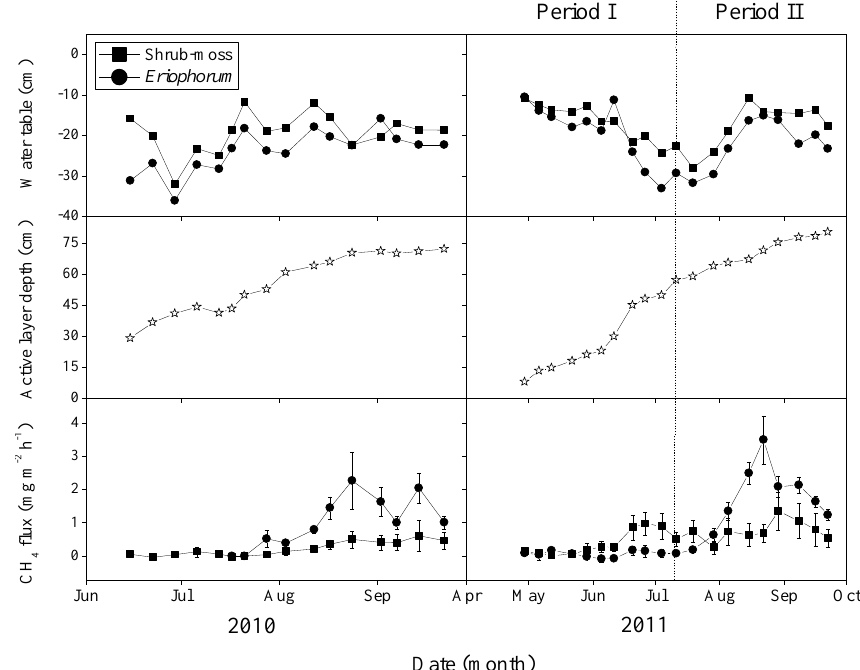
Fig. 3. The seasonal variation of net CH 4 fluxes and environmental variables (water table and active layer depth) observed at the study site during the growing seasons of 2010 and